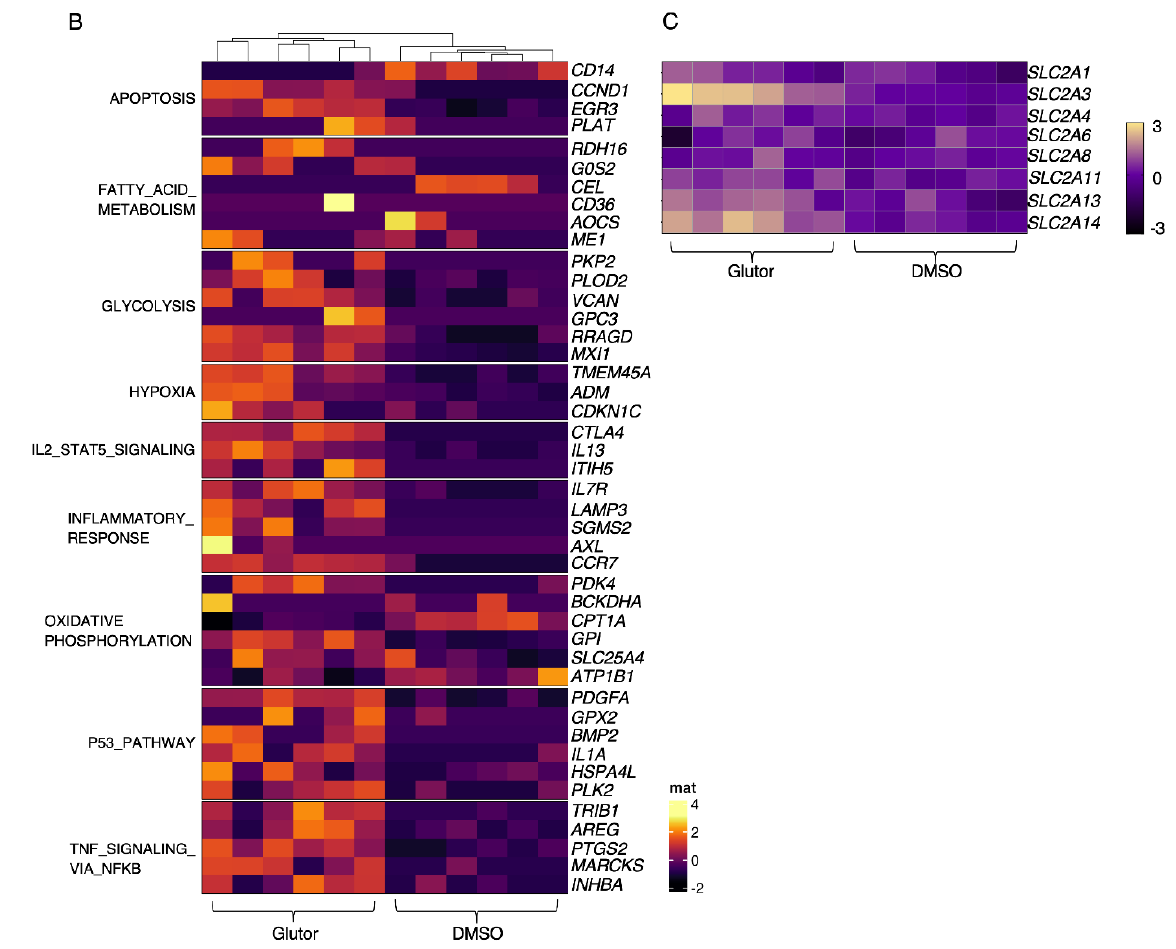
Figure 4. RNA sequencing analysis of Glutor-treated NK cells. ( A ) GSEA of long-term treated NK cells: n = 6. ( B ) Heatmap containing top 6 genes of significantly enriched hallmark gene sets: hallmark apoptosis, hallmark fatty acid metabolism, hallmark glycolysis, hallmark hypoxia, hallmark Il2 STAT5 signaling, hallmark inflammatory response, hallmark oxidative phosphorylation, hallmark p53 pathway, hallmark TNF- α signaling via NF- κ B: n = 6. ( C ) Heatmap containing different SLC2A genes of long-term treated NK cells: n =